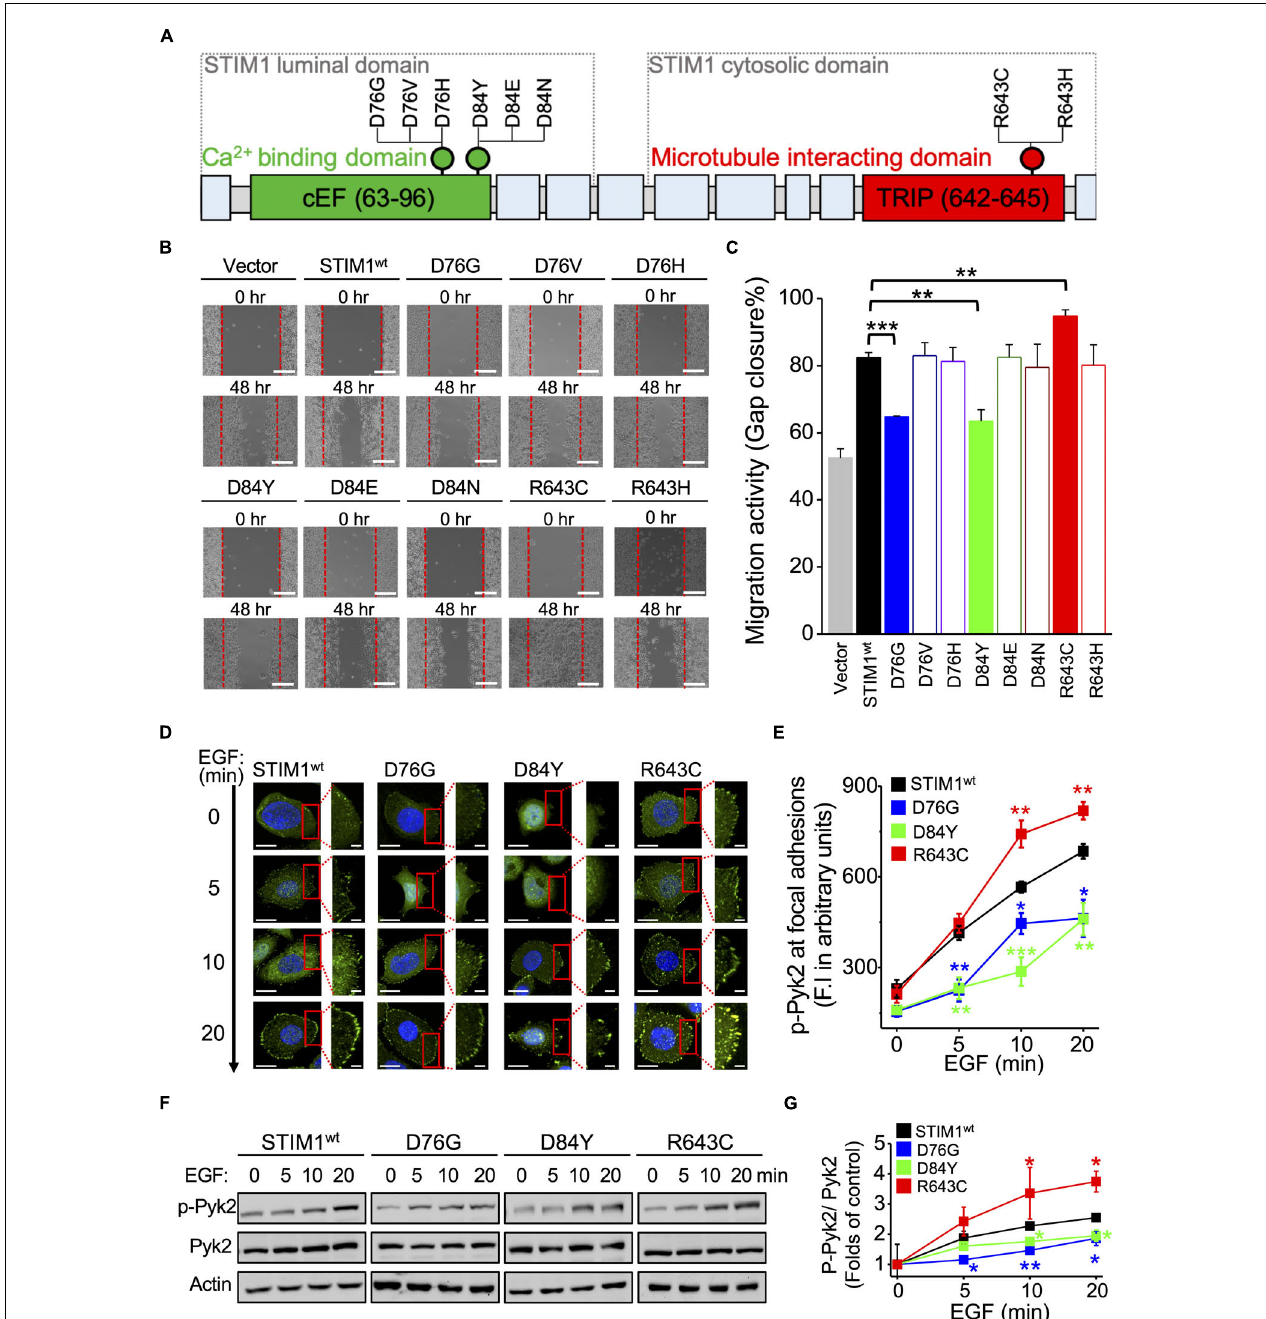
FIGURE 6 | Somatic mutations in STIM1 differentially regulate cancer cell migration by focal adhesion turnover. (A) The molecular domains of STIM1 and the variants located on the cEF hand and S/TxIP motif. (B) Migratory activities of SiHa cells with different STIM1 variants assessed by gap closure assay. Representative images at indicated time points from at least three independent experiments. The red dashed lines indicate where migration began. Scale bar, 200 µ m. (C) Quantitative analyses of the migration activity of SiHa cells with different STIM1 variants. Gap closure area quantified using the ImageJ software was taken as the index of cell migration activity. Column, mean ± SEM from at least three independent experiments. ** P < 0.01, *** P < 0.001, compared with wild-type group by one-way ANOVA with a Dunnett’s post hoc test. (D) Representative images showing staining for p-Pyk2 (green) in SiHa cells with different STIM1 variants. Scale bar, 10 µ m. (E) Quantitative analyses of p-Pyk2 staining in SiHa cells with different STIM1 variants. Column, mean ± SEM from at least five different cells of three independent experiments. * P < 0.05, ** P < 0.01, *** P < 0.001, compared with wild-type group by one-way ANOVA with a Dunnett’s post hoc test. (F) The STIM1 mutations affect EGF-stimulated Pyk2 phosphorylation. Representative immunoblots from at least three independent experiments. (G) Densitometric quantification of Pyk2 phosphorylation (Tyr402) levels. Value, mean ± SEM from three independent experiments. * P < 0.05, ** P < 0.01, compared with wild-type group by one-way ANOVA with a Dunnett’s post hoc